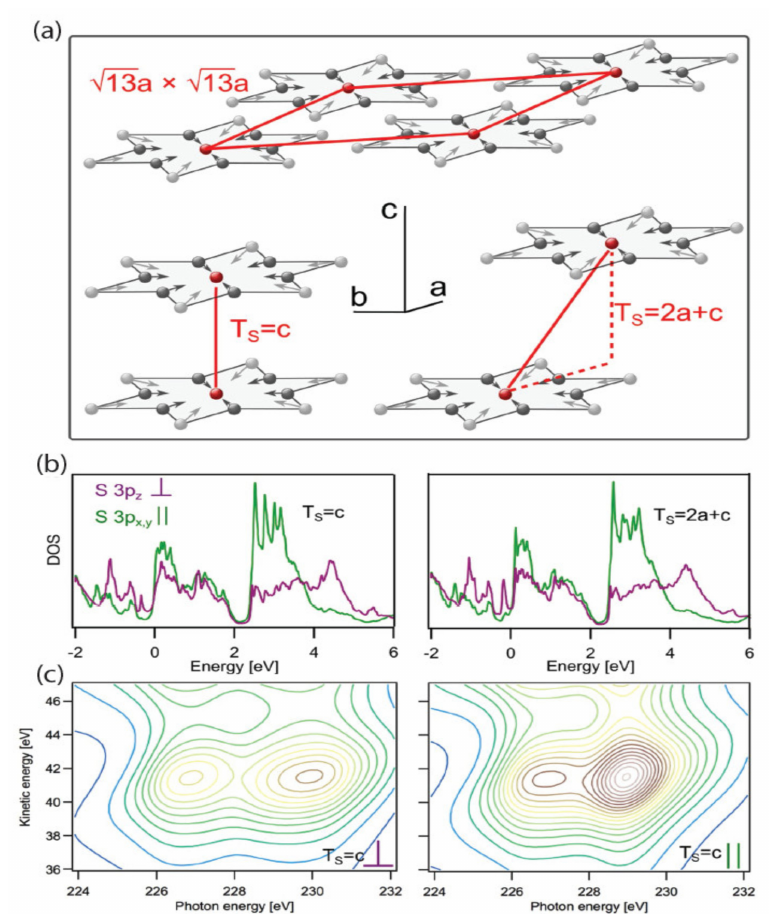
Figure 17. DFT calculations of the electronic structure and spectral signatures of 1 T -TaS 2 are shown for two C-CDW interlayer stacking arrangements. ( a ) The 13 a × 13 a Star-of-David reconstruction of the Ta layers is illustrated. All atoms of each star are displaced (depicted with arrows) toward the center atom. Bottom left: CDW stacking of the Ta planes with the Star-of-David centers on top of each other (T s = c). Bottom right: CDW stacking with a stacking vector having an in-plane component (T s = 2a + c). ( b ) DFT calculations of the PDOS of the polarized S 3 p states with on-site S 2 s core hole for T s = c ( left ) and T s = 2a + c ( right ). Purple shows the out-of-plane PDOS, and green shows the in-plane PDOS. The Fermi level is located at 0 eV. ( c ) Simulations of the sulfur scattering planes based on the PDOS from ( b ). Intensity increases from blue to brown. Reference [157] is